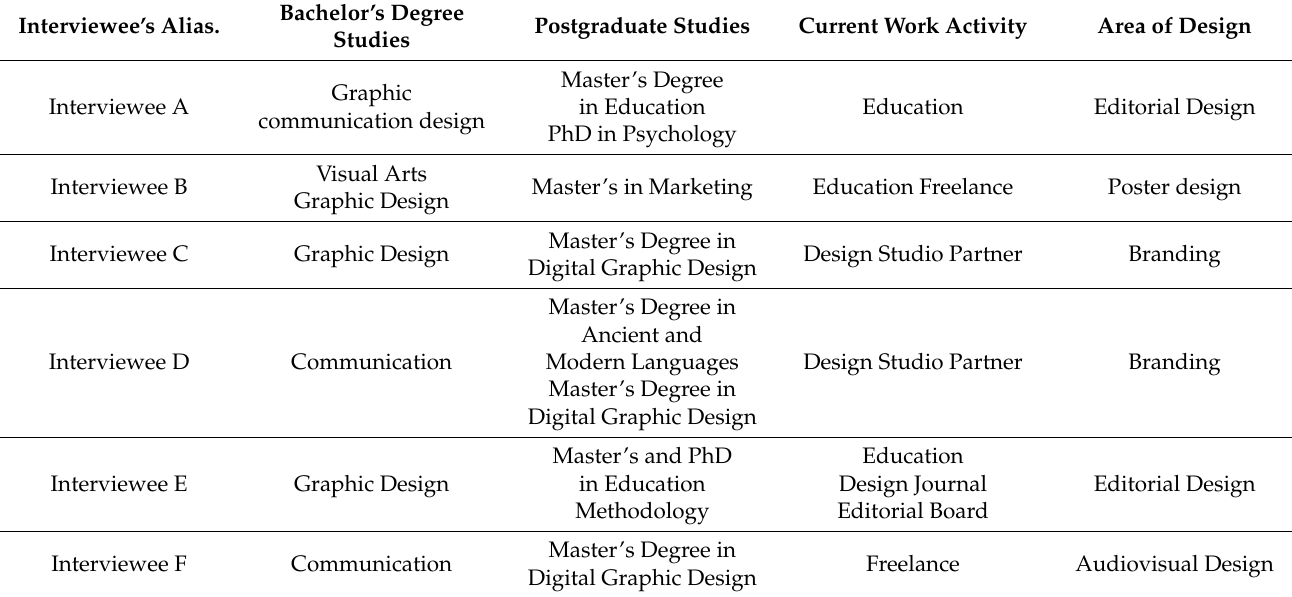
Table 1. Profile of the interviewees (own